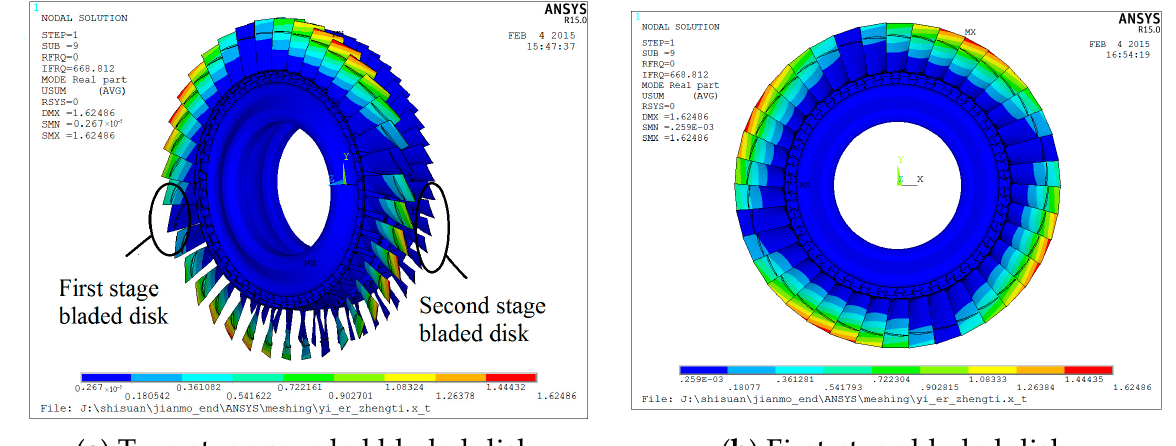
Figure 17. Two-pitch coupled vibration of the blade and disk.